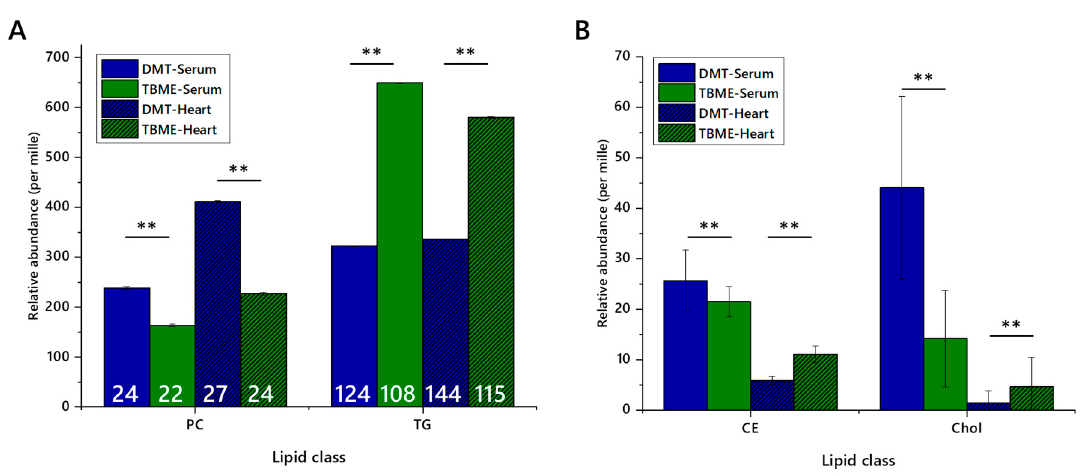
Figure 2. Relative abundance of lipid classes and the numbers of lipid isoforms (variables) in each class, extracted from either murine heart or human serum using either TBME or DMT. Blue columns show DMT extracts, and green columns show TBME extracts. Hatched columns represent serum samples, whereas open columns represent heart samples. Number of variables are shown in white figures. Panel ( A ), abundance of phosphatidylcholines and triglycerides with number of variables marked; ( B ), abundance of cholesteryl esters and cholesterol. Five isoforms of cholesteryl ester were identified. Error bars show standard error. CE, cholesteryl ester; Chol, cholesterol; PC, phosphatidylcholine; TG, triglyceride. ** p < 0·001. 2.2 Coefficient of Variance In order to test the precision of the DMT method, four subtypes of each matrix were employed. Commercially-available milks from four different sources (Jersey and ordinary bovine milk, caprine milk and soya drink), and two pools of homogenates prepared from tissues from mice of two different feeding phenotypes, were used. Multivariate analysis (principal component analysis, PCA in Figure 3) showed that the profiles of these groups divided up as expected, with two broadly similar pairs of profiles of lipids from murine hearts and four distinct groups for milk extracts. The latter was shaped by the difference between soya drink and the three animal milks. However, the difference between them was clear from their profile in positive ionisation mode. This was as expected; around 98% of the lipophilic material extracted from milk is the tri- and diglycerides, which ionise very well in positive mode and only poorly in negative mode.